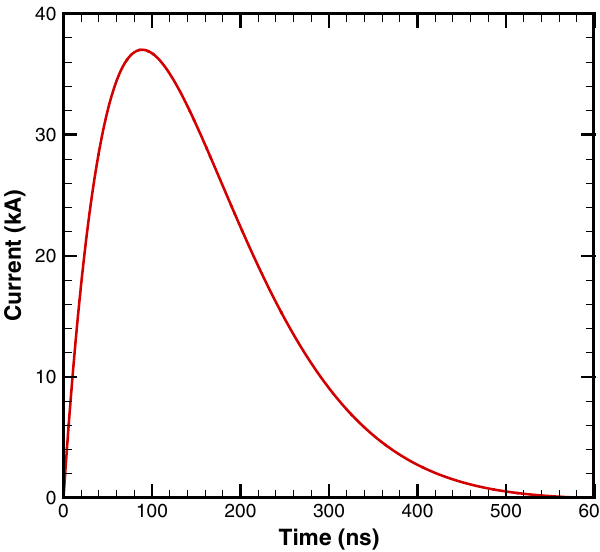
FIG. 3. Current versus time for a single brick into 3 10 Ω cables. Equivalent total cable impedance is 3 . 3 Ω and brick impedance is 3 . 0 Ω . Initial capacitor charge is þ = − 100 kV.